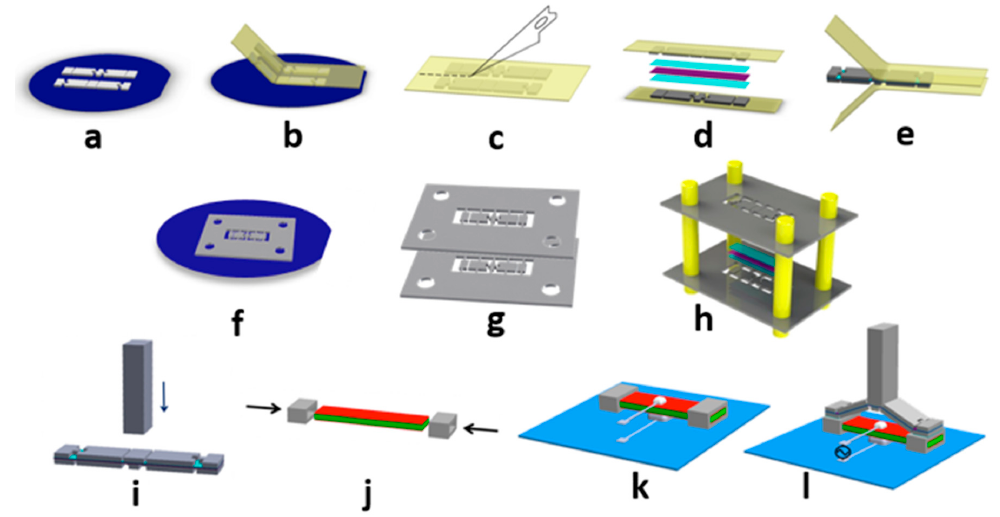
Figure 2. Fabrication process for the motion-amplifying half-scissor actuator. Images ( a – e ) show the actively aligned assembly, including ( a ) photolithographically patterning a layer of 200- µ m-thick SU-8 2150 on a wafer substrate coated with a 15-nm-layer of Omnicoat™ release layer; ( b ) transferring the SU-8 parts from wafer to polyimide carrier tape by dissolving the Omnicoat™ layer; ( c ) separating the upper and lower sets of SU-8 parts; ( d ) laminating the polyimide film, adhesives, and both sets of SU-8 parts; and ( e ) peeling off the polyimide carrier tape. Images ( f – h ) show the passively aligned assembly, including ( f ) photolithographically patterning the linkages in supporting frames; ( g ) releasing the frames from the wafer, and ( h ) aligning the assembly of the scissor elements onto a polyimide tape. Images ( i – l ) show the final assembly via solder-based packaging, including ( i ) attaching the tactile interface pin on the central stage of the motion amplifier; ( j ) attaching the SU-8 clamps (fabricated separately) to the PZT extensional actuator; ( k ) soldering the PZT’s upper and lower electrodes to the printed circuit board; and ( l ) adhering the motion amplifier to the PZT actuator to complete the device.